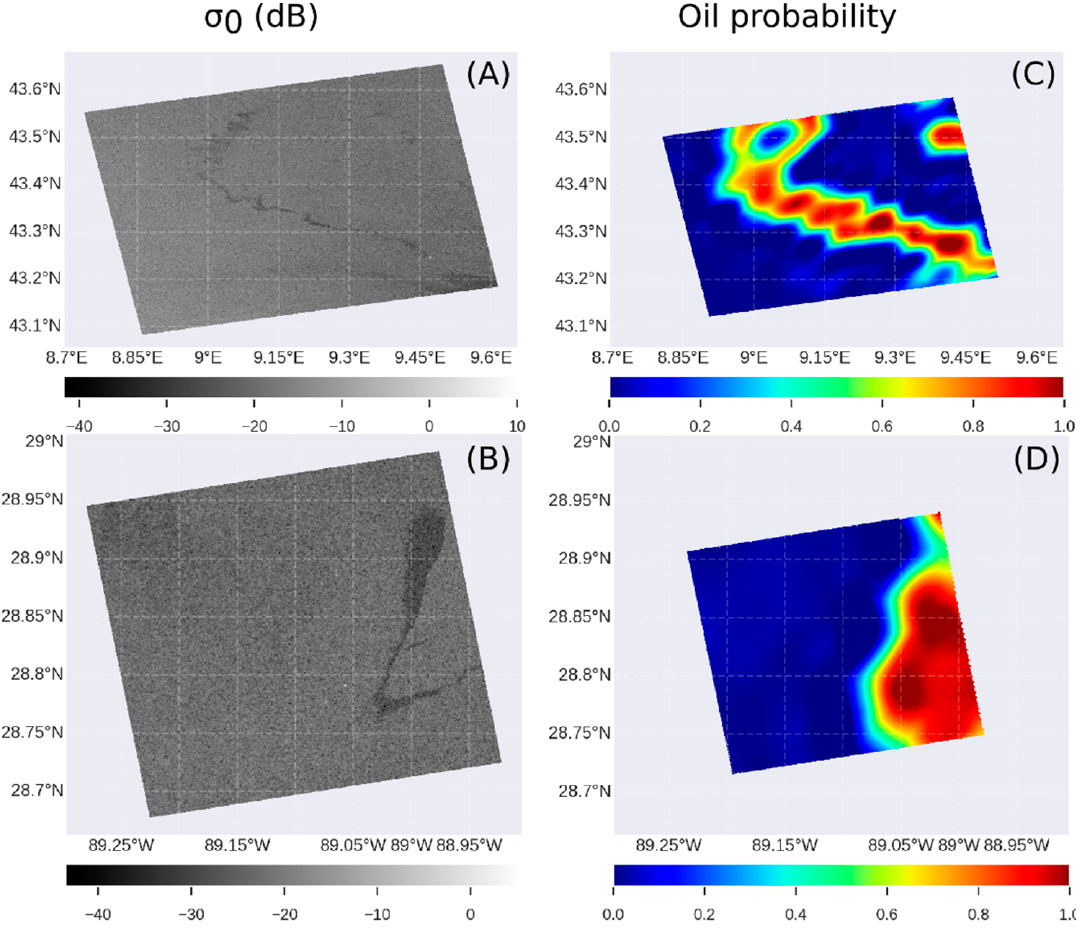
Figure 9. Oil spill images ( A and B ) and their associated oil presence probability as calculated from a two-class random forest detector model ( C and D ).